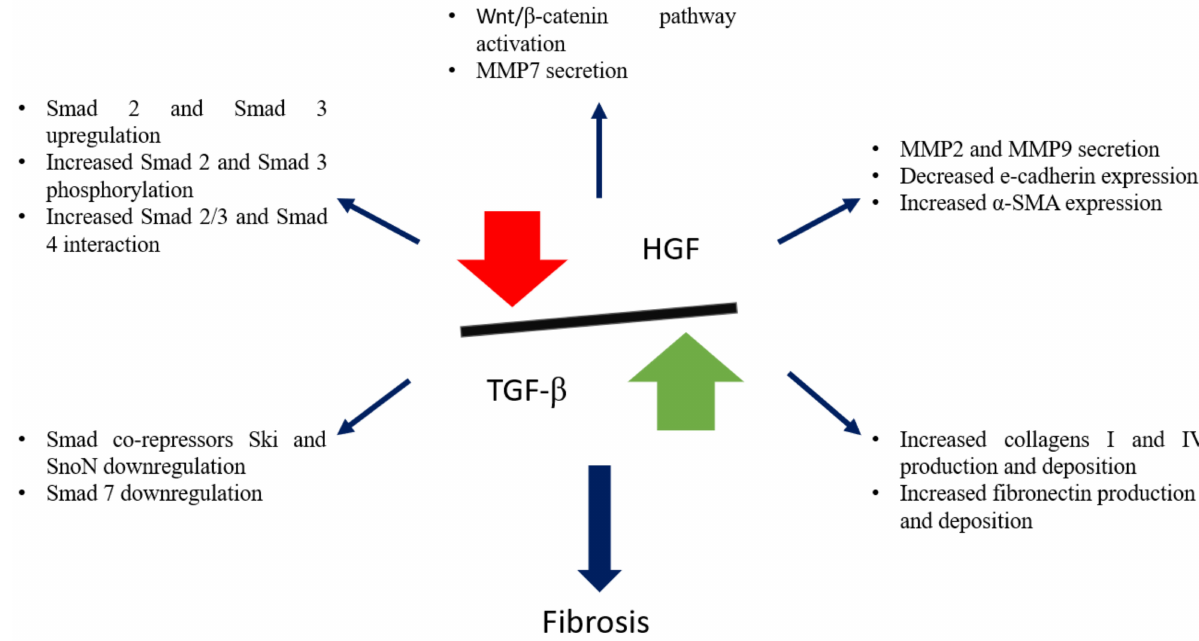
Figure 3. Schematic representation of TGF- β 1 and HGF balance, and its importance in kidney